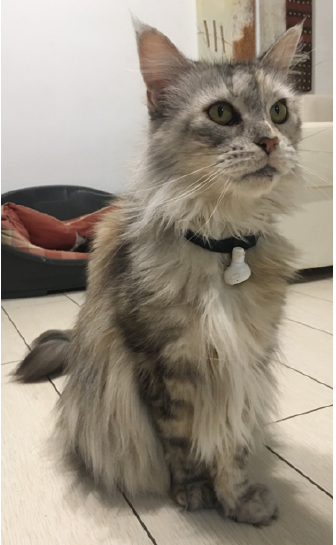
Figure 1. A cat provided with a Bluetooth microphone placed on the